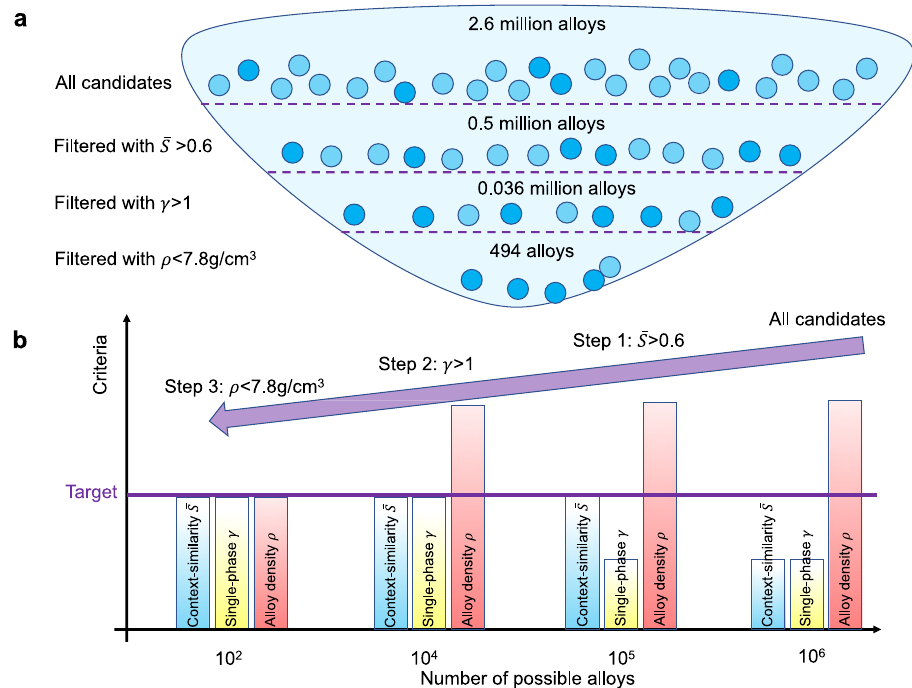
Fig.4|Anexemplarydesignoflightweighthigh-entropyalloyswithmorethan fi ve components. a We show the example study conducted for six- and seven- component single-phase, equiatomic alloys, limited to 30 transition-metal ele- ments.The fi rststepistocalculatetheaveragecontextsimilarity (cid:1) S andselectalloys with a (cid:1) S >0 : 6. The distributions of (cid:1) S for all these candidates are shown in Supple- mentaryFig.5.Thesecond fi lteringstepisto fi